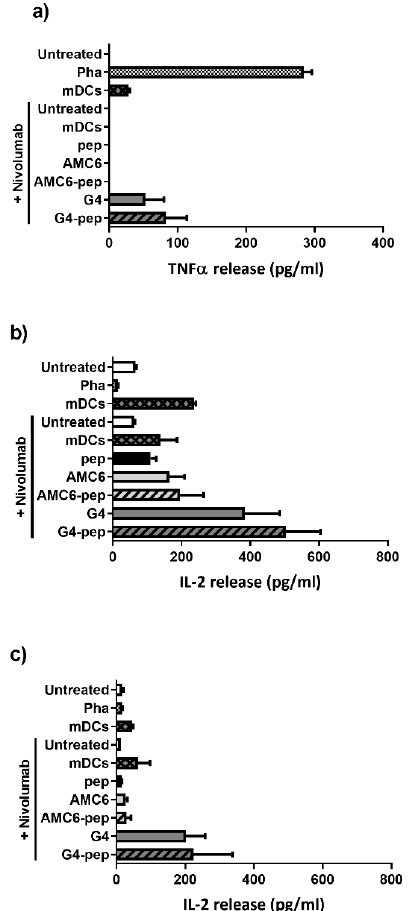
Figure 8. Cytokine release to the MLR media from PBMCs. Cytokine concentration in the extracellular media of the MLR was measured using a DIAplex kit. Significant changes were observed on the expression of IL-12 ( a ), TNF- α ( b ) and IL-2 ( c ). The results shown correspond to the highest concentration of nivolumab used (10 µ g / mL) at day 3 ( c ) or day 6 ( a , b ) of co-culture. Untreated PBMCs and PHA-activated PBMCs (Pha) are negative and positive controls respectively. PBMCs treated mDCs (without nivolumab) are also used as controls. All the other samples were treated with nivolumab. Abbreviations: Pha = phytohemagglutinin, pep = peptide, G4 = G4-70 /